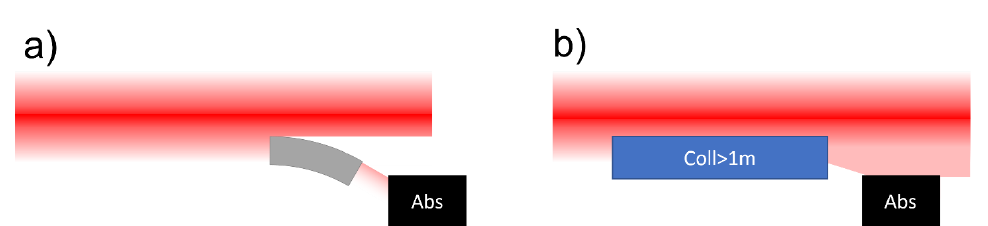
Figure 4. ( a ) collimation scheme using a bent crystal, beam halo is precisely directed onto the absorber where it is stopped. ( b ) amorphous collimator scatter beam halo over an angular spread corresponding to the multiple scattering angle to be intercepted by downstream